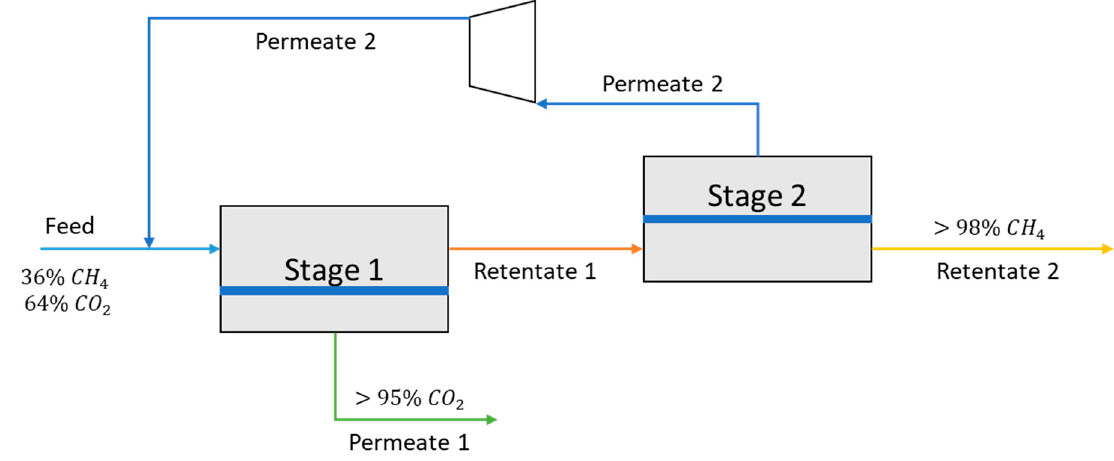
Figure 15. Membrane process for natural gas sweetening produced via depressurisation and CO 2 replacement.